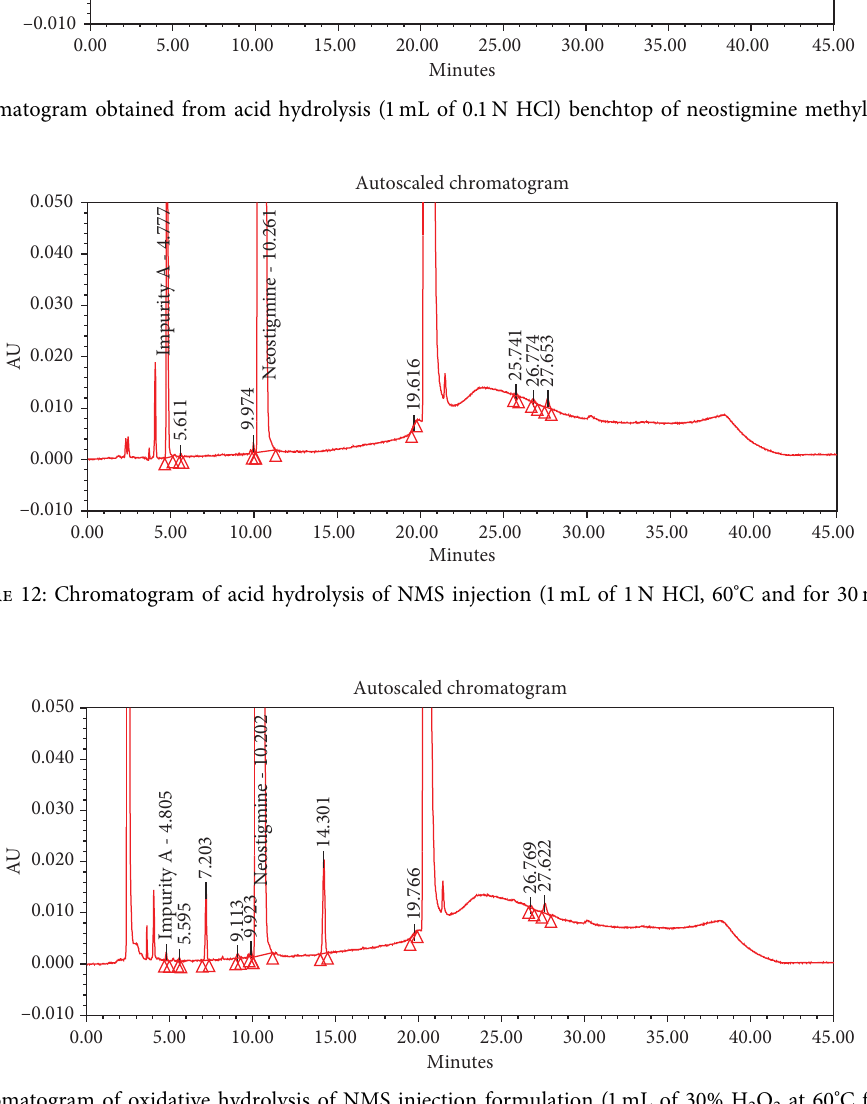
° C for 30 minutes). 2 O 2 at 60